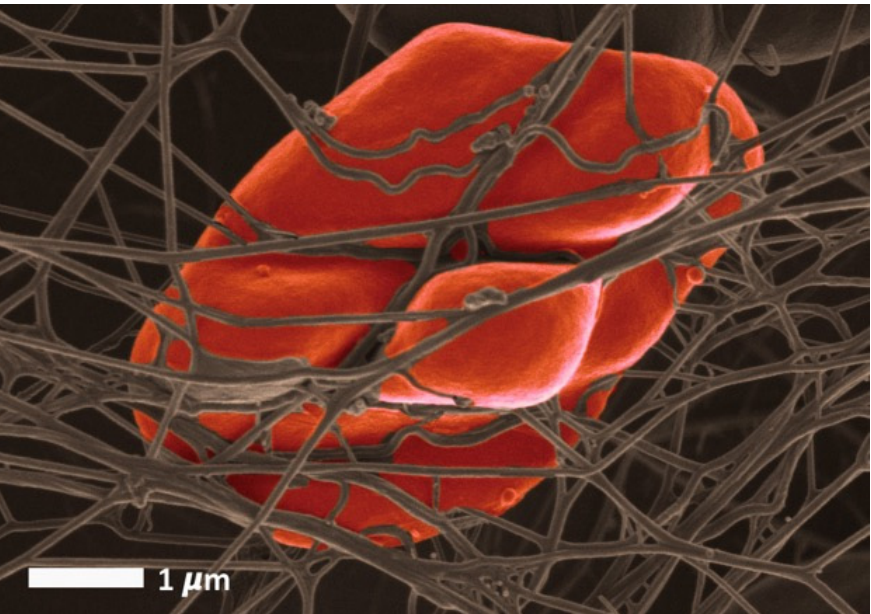
Figure 3. A representative RBC from a type 2 diabetes patient (Raw data from [83]. Erythrocyte deformability is often found to be moderately impaired in diabetes mellitus patients, due to several metabolic and hormonal disturbances (glycation and oxidative stress) that may also promote eryptosis. This is an example of “covertly abnormal blood rheology”, which is supposed to induce microcirculatory disturbances. The main glucose-regulating hormones insulin and glucagon have also been reported to exert an influence on red cell deformability, whose pathophysiological relevance remains unclear.